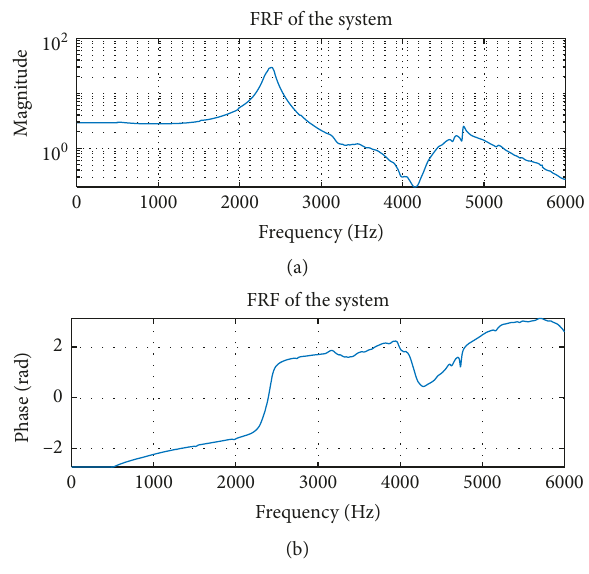
Figure 14: FRF of the experimental